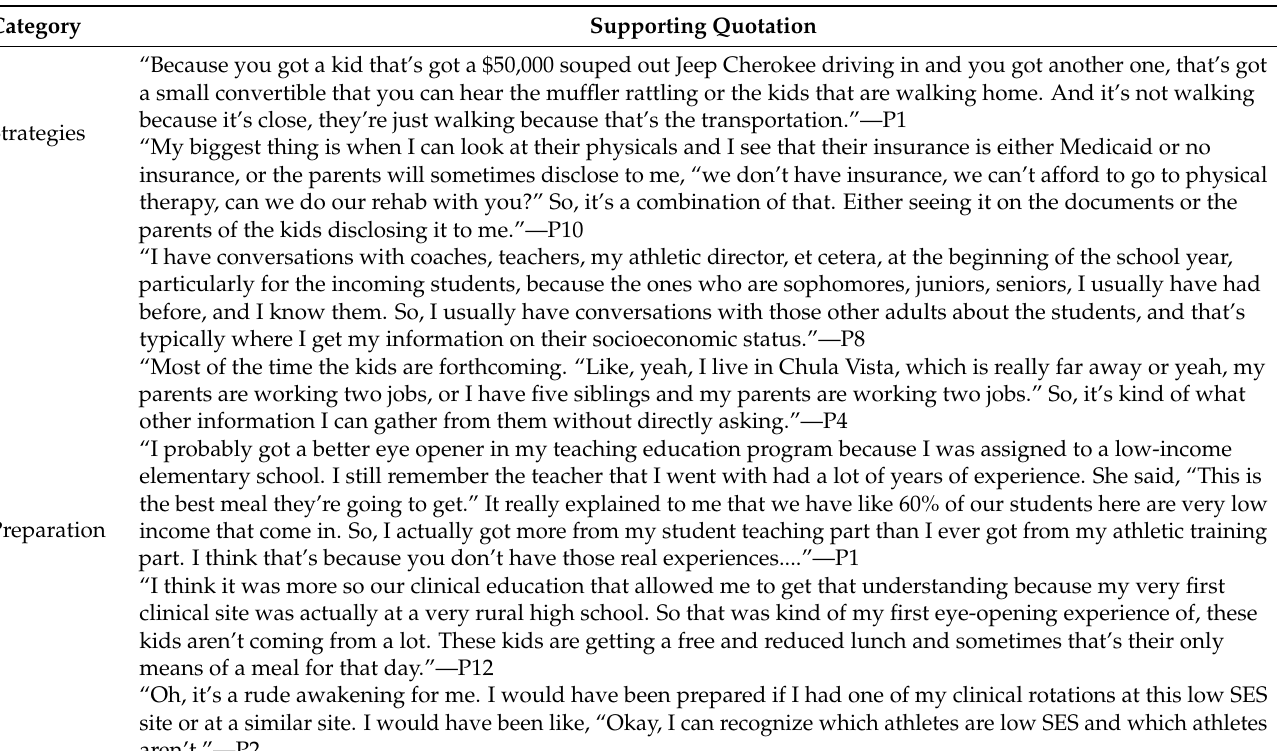
Table 3. Mechanisms for Identifying Socioeconomic